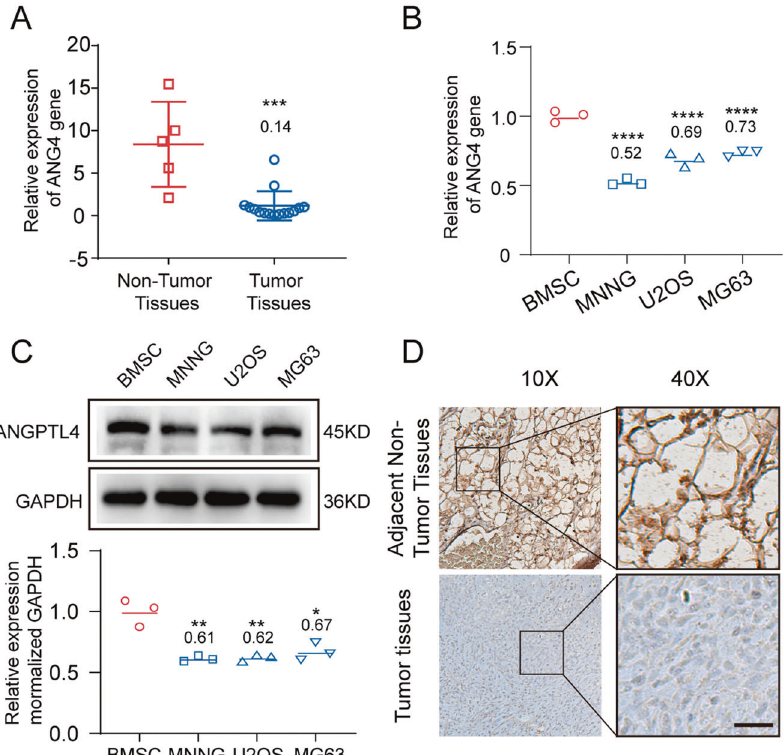
Fig. 1 ANGPTL4 expression is lower in osteosarcoma tissue and osteosarcoma cell lines. A Relative mRNA expression of ANGPTL4 in clinical osteosarcoma (OS) tissue samples ( N = 15) and adjacent nontumor cancellous bone tissue samples ( N = 5) (*** p < 0.001 vs. the normal tissue group). B Relative mRNA expression of ANGPTL4 in OS cell lines (MNNG, U2OS, MG63) and bone marrow-derived stromal cells (BMSCs). ( N = 3, **** p < 0.0001 vs. the BMSC group). C ANGPTL4 expression (upper panels) and quantitation of protein levels (lower bar graphs) in OS cell lines and BMSCs were detected by western blot ( N = 3, * p < 0.05, ** p < 0.01 vs. the BMSC group). D Representative immunohistochemical images of ANGPTL4 in clinical OS sample and adjacent nontumor bone marrow sample ( D , scale bars, 100 μ